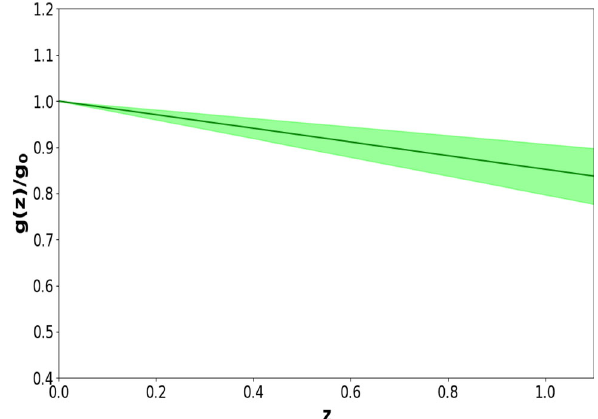
of redshift for gas mass fraction measurements within r 2500 or r 500 (see, for instance, the Tables II and III from the Ref.